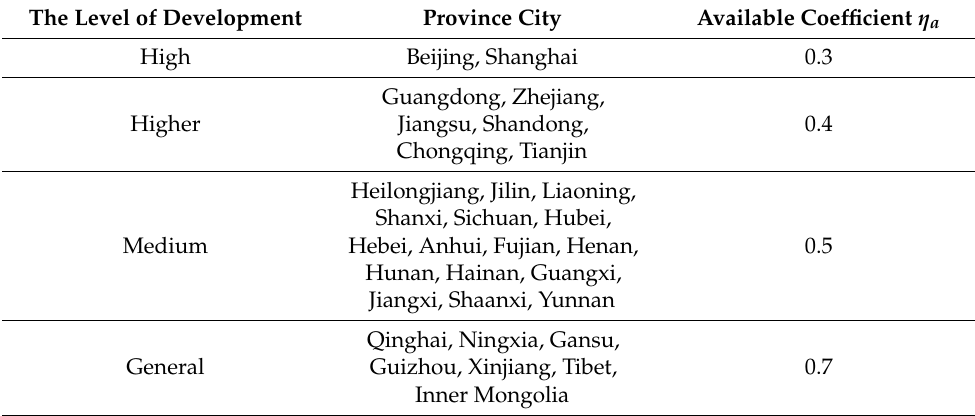
Table 3. Values of the available coefficient η a of cities in different provinces in China. The Level of